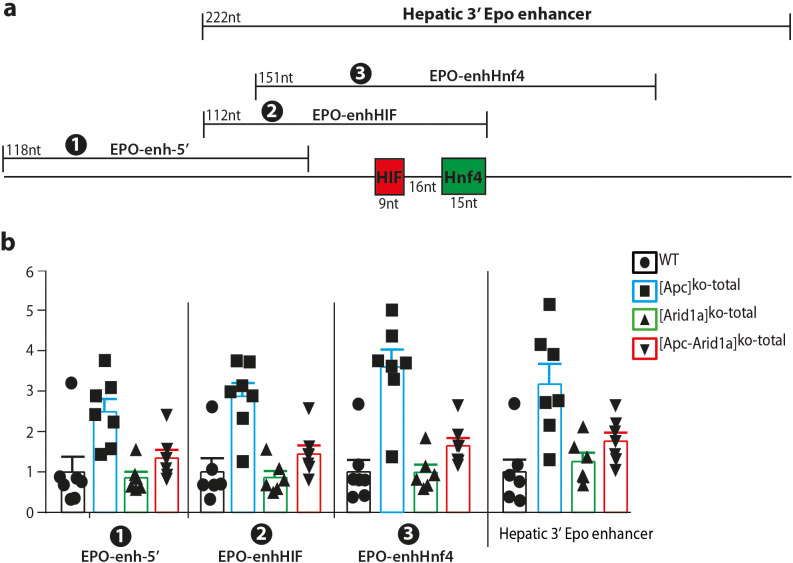
Chromatin accessibility assessed all along the hepatic 3’Epo enhancer by ATAC-qPCR.(a) The hepatic 3’ Epo enhancer with the 4 PCR products analyzed: the whole hepatic 3’ Epo enhancer (222nt); (1) the EPO-enh-5’ located upstream the HIF- and Hnf4- responsive elements; (2) the EPO-enhHIF centered on the HIF-responsive element; (3) the EPO-enhHnf4 centered on the Hnf4 responsive element. In any case, the chromatin from Apcko hepatocytes is more accessible compared to WT chromatin, and the highest accessibility occurs on EPO-enhHnf4 both for [Apc]ko-TOTAL and [Apc-Arid1a]ko-TOTAL chromatin. Data are analyzed with two-way ANOVA. ****p<0.0001.Figure 8—figure supplement 2—source data 1.ATAC-qPCR data (Figure 8—figure supplements 2b).